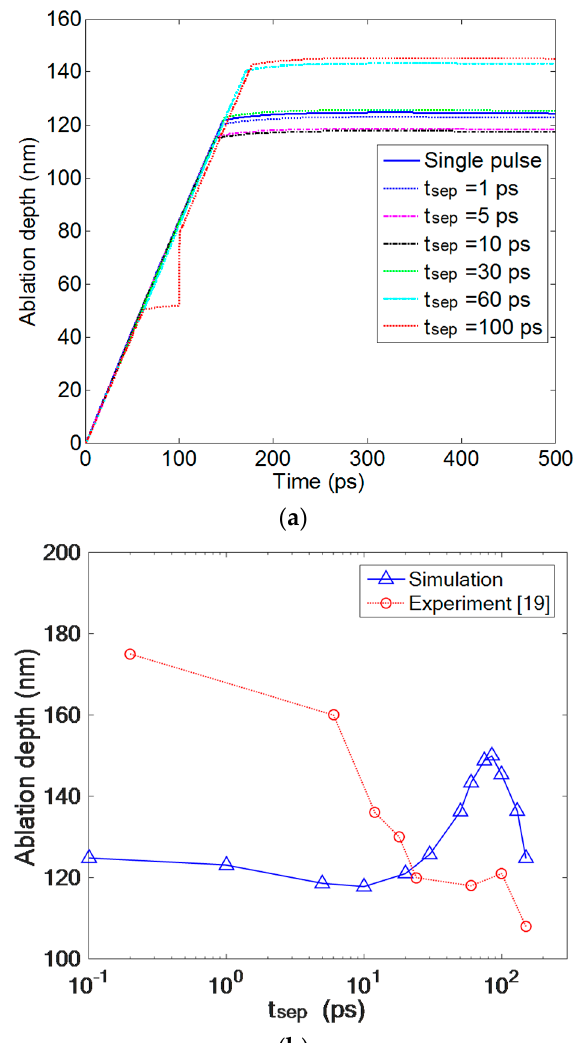
Figure 3. ( a ) Time history of ablation depth resulting from different laser pulses and ( b ) ablation depth as a function of separation time, with a total laser fluence of 4.0 J/cm 2 .